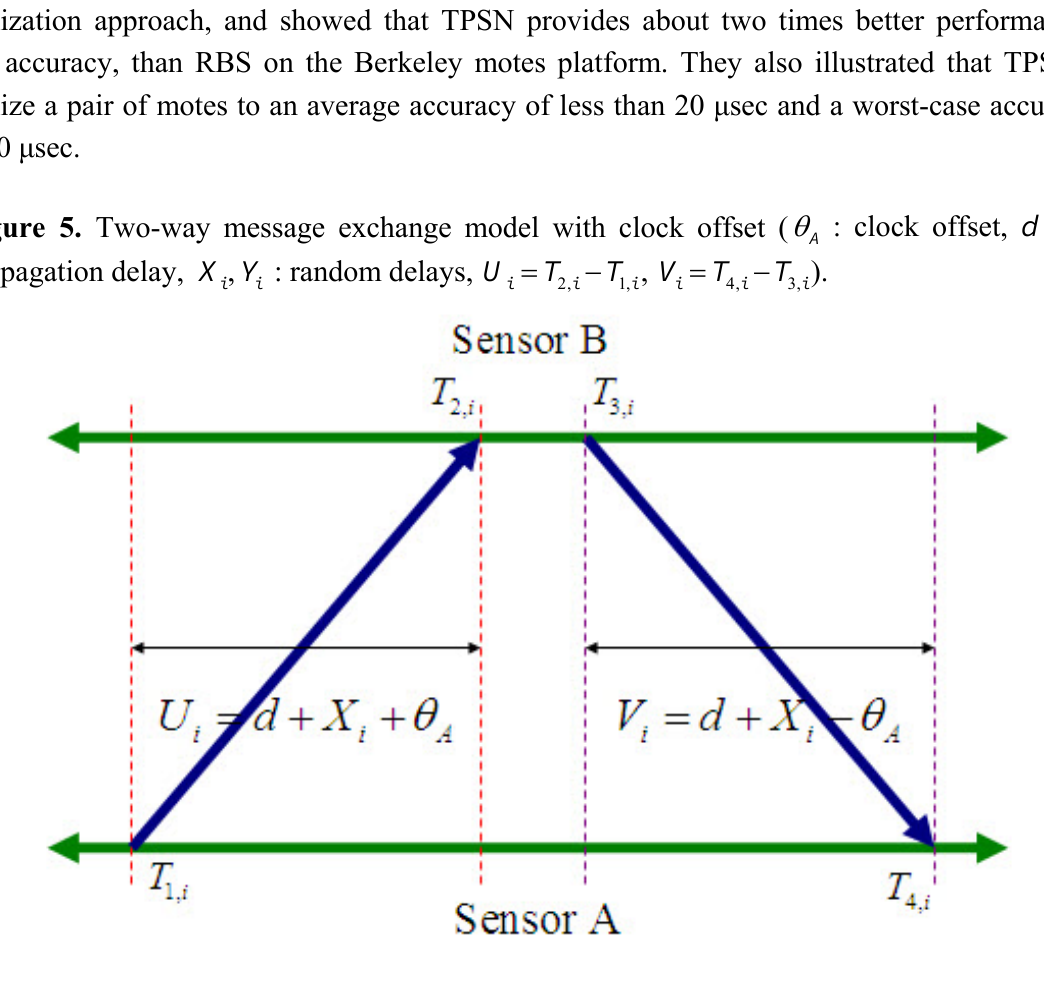
 : clock offset, d : A